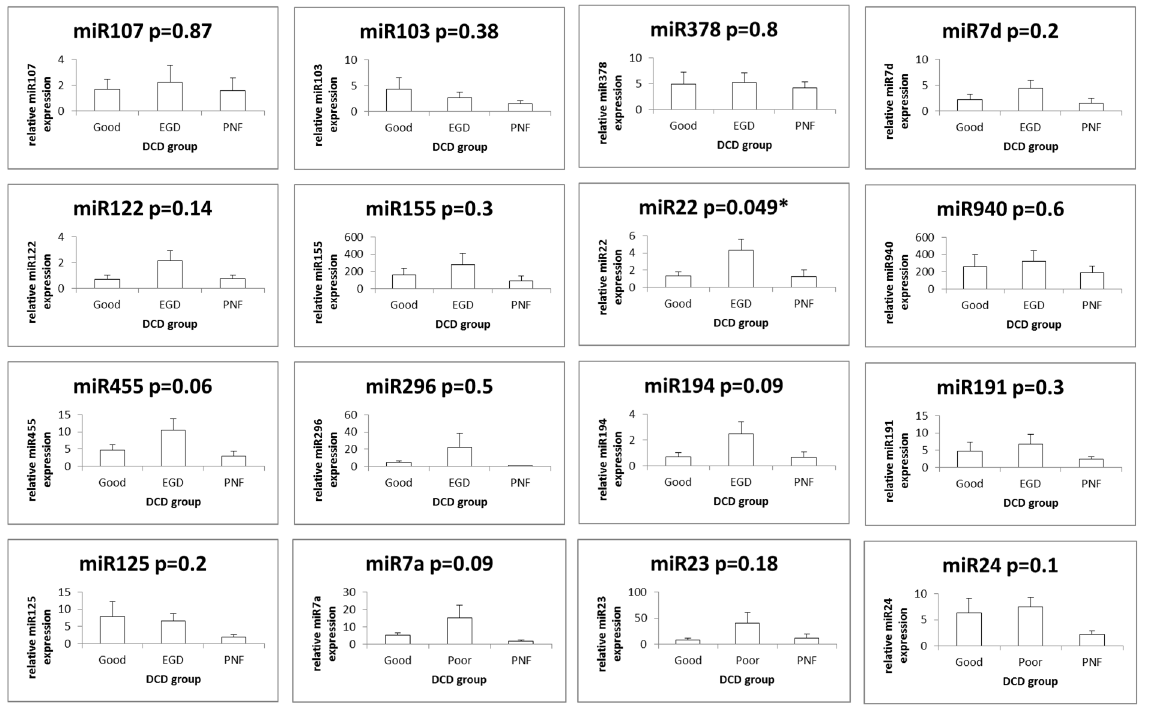
Fig 4. Real time quantitative PCR of individual microRNA. From the microRNA (miRNA) array analysis 16 miRNAs were identified as having significant differential expression (p < 0.05) and selected for further validation with real time quantitative PCR (RT-qPCR). Threshold cycle (Ct) values were normalised using the average Ct of small nucleolar RNAs (snoRNAs) and to determine miRNA relative expression 2 ΔΔ CT was used and calculated as follows Δ CT (miRNA Ct — averaged endogenous control Ct) and fold-change to reference sample of normal liver (a non steatotic donation after brain stem death liver). Due to the range and magnitude of relative miRNA expression, data was log transformed and presented as mean +/- SE. The relative expression for a given miRNA in the three donation after cardiac death (DCD) liver groups of primary non function (PNF) retransplanted within a week (n = 7), good functional outcome (n = 7) peak aspartate transaminase (AST) (cid:1) 1000 IU/L and early graft dysfunction (EGD) (n = 9) peak AST (cid:3) 2500 IU/L is represented graphically. The observed differences in the relative expression of a given miRNA species on RT-qPCR between the three DCD liver groups was only found to be significant for miR-22 (p = 0.049).